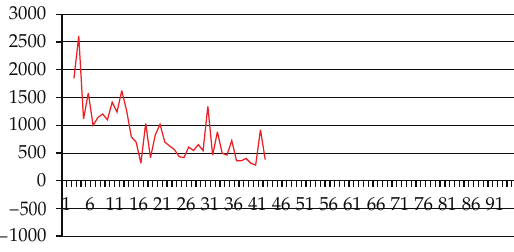
Figure 4: The time series of rehabilitation group NIHSS baseline unit cost e ff